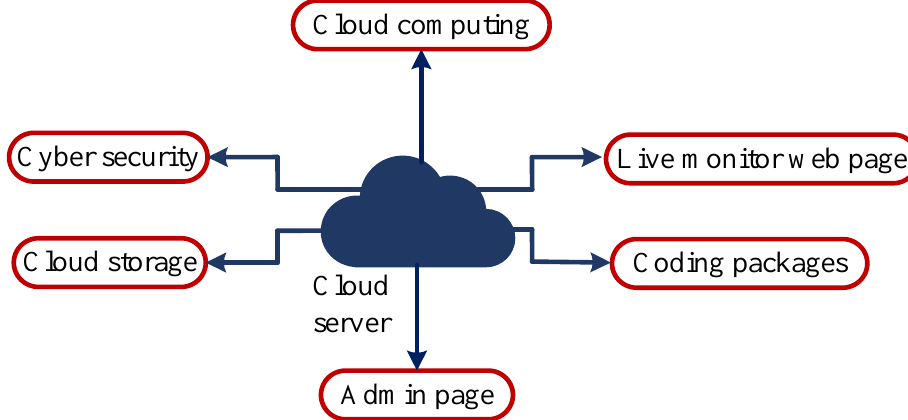
Figure 4. An overview of the cloud service’s components.